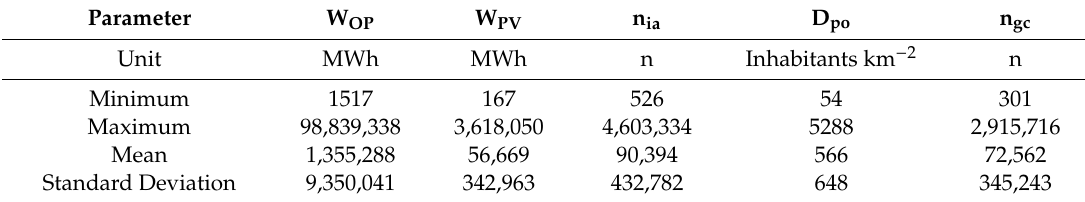
Table 5. Basic statistical parameters for selected attributes of the data